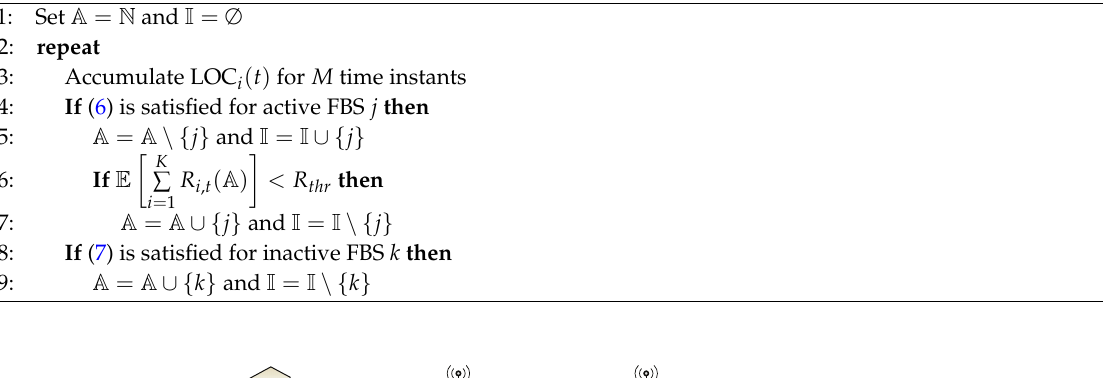
Algorithm 1 On–Off power control of femto-cell base station (FBS) based on the level of contribution (LOC)